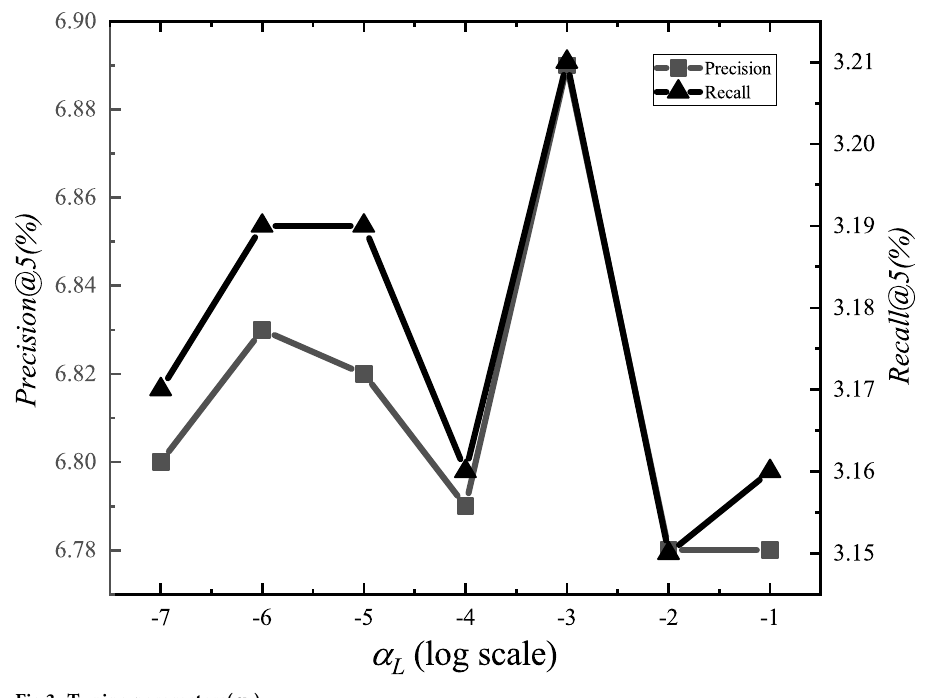
Fig 3. Tuning parameters( α